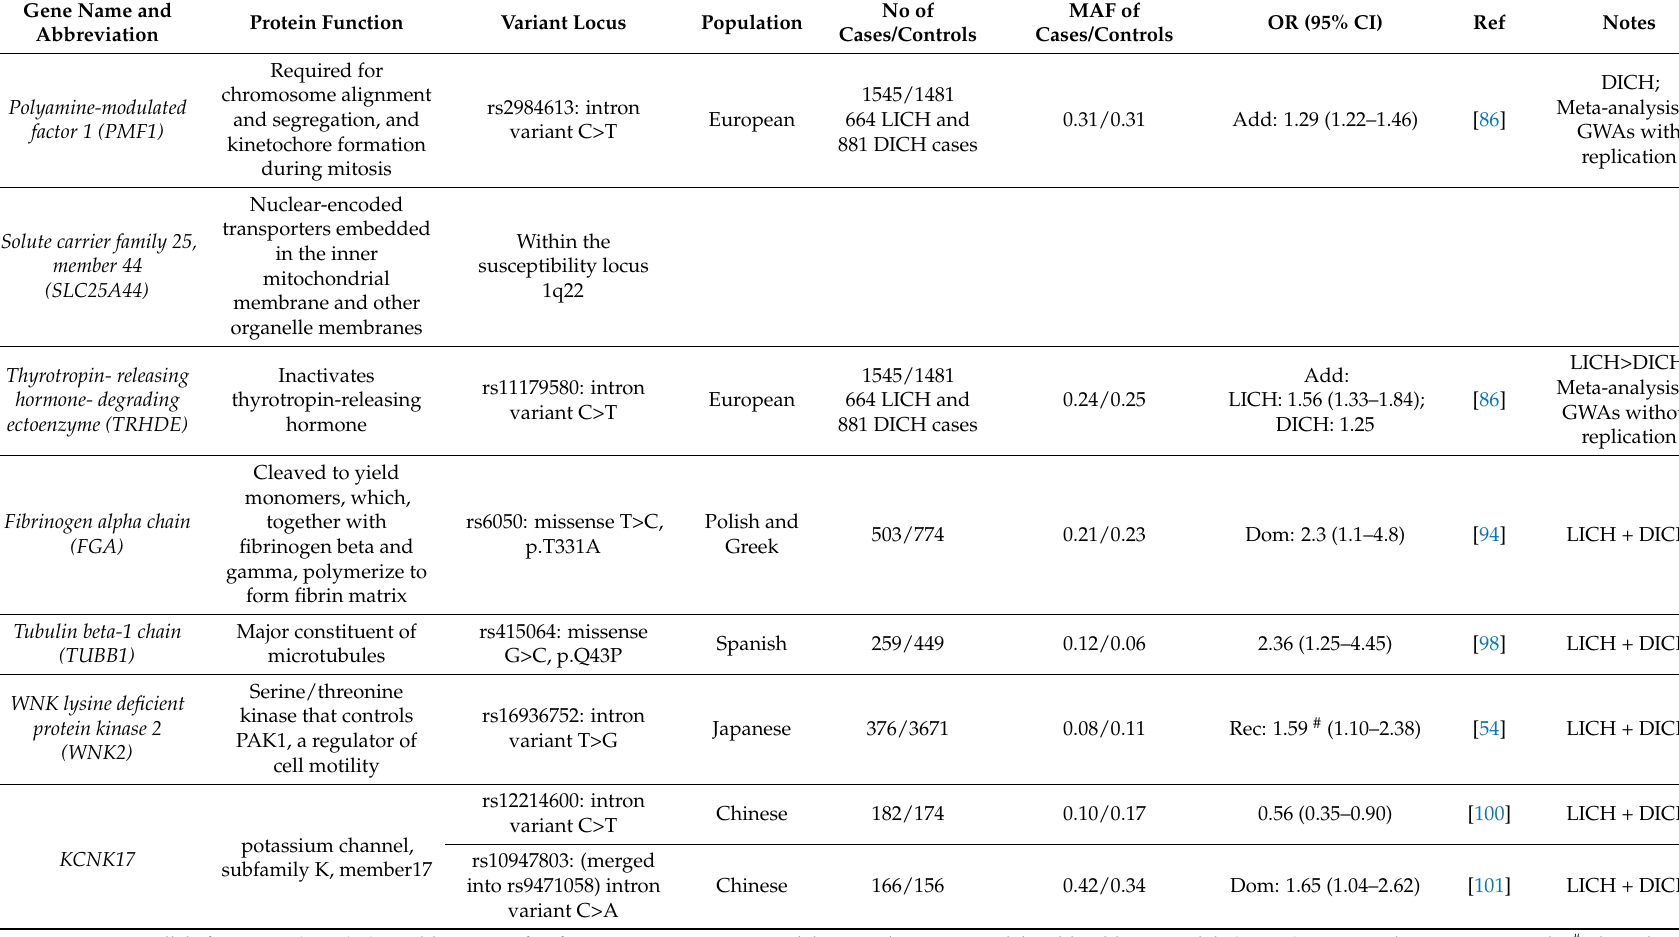
Table 4. Variants associated with ICH: